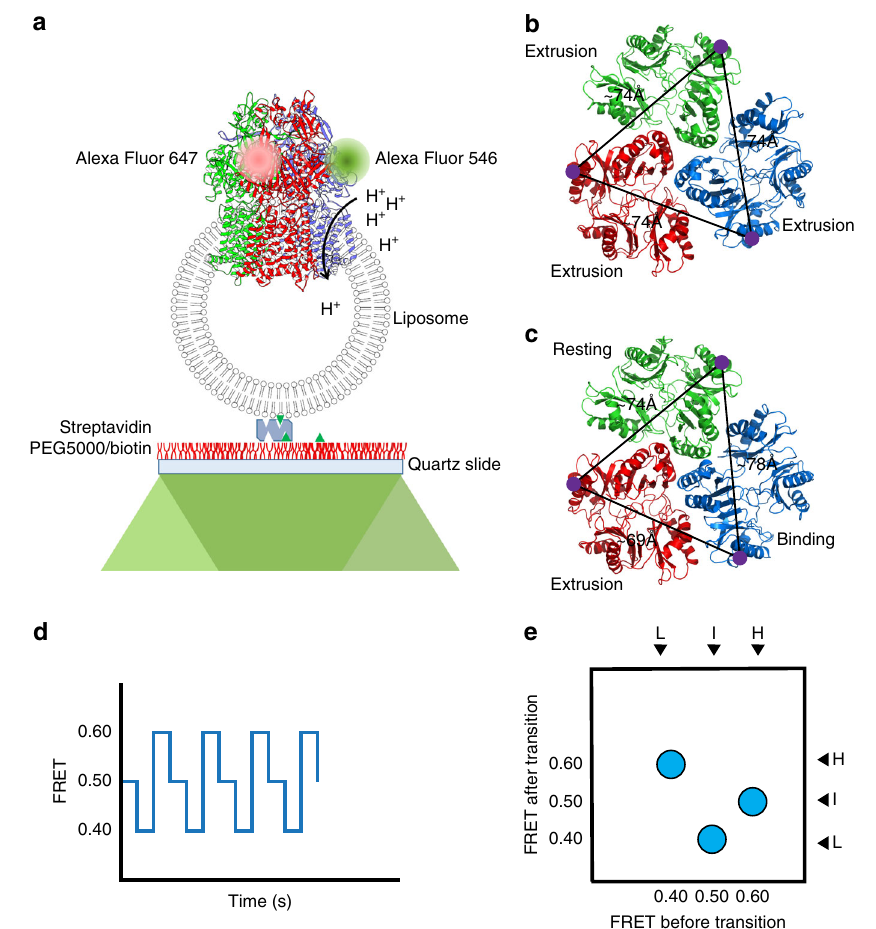
Fig. 3 Schematic diagram for visualizing the dynamics of the trimeric CmeB pump incorporated in proteoliposomes using total internal re fl ection sm-FRET imaging. a The three subunits of CmeB embedded in the lipid vesicle are colored differently. The AF546 and AF647 dyes are in green and magenta , respectively. b Inter-subunit distances measured between the two K843 residues of the form I CmeB trimer. c Inter-subunit distances measured between the two K843 residues of the form II CmeB trimer. d The predicted FRET trajectory and e predicted density plot of the transport dynamics of the